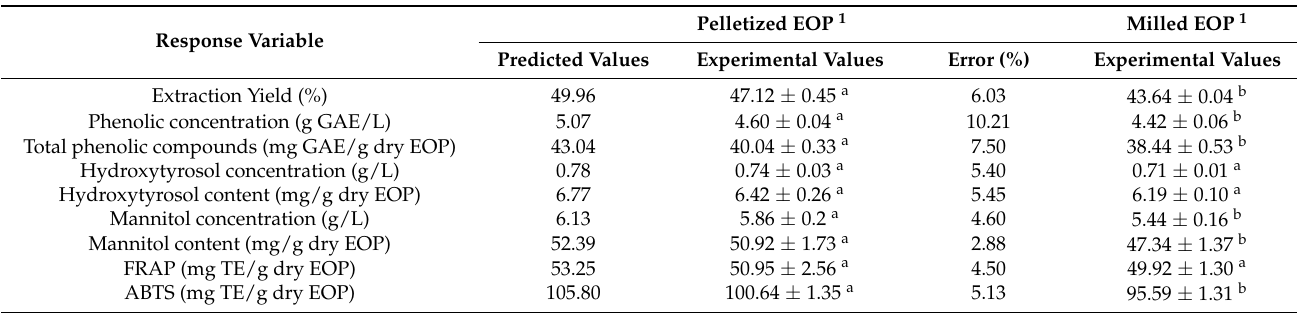
Table 4. Predicted and experimental values obtained by ultrasound-assisted water extraction of exhausted olive po- mace (EOP) under optimal conditions and comparison with milled EOP. Data represent the mean value ± standard deviation ( n =